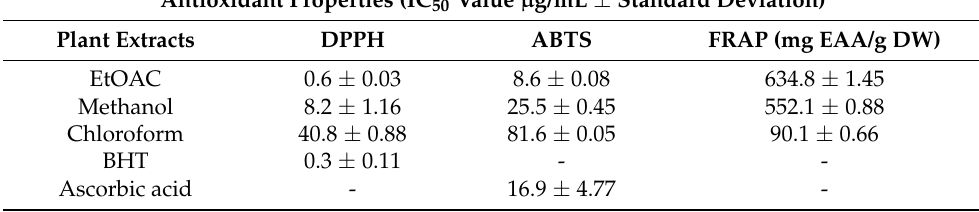
Table 2. Antioxidant activity of Inula viscosa (L.) Aiton extracts.